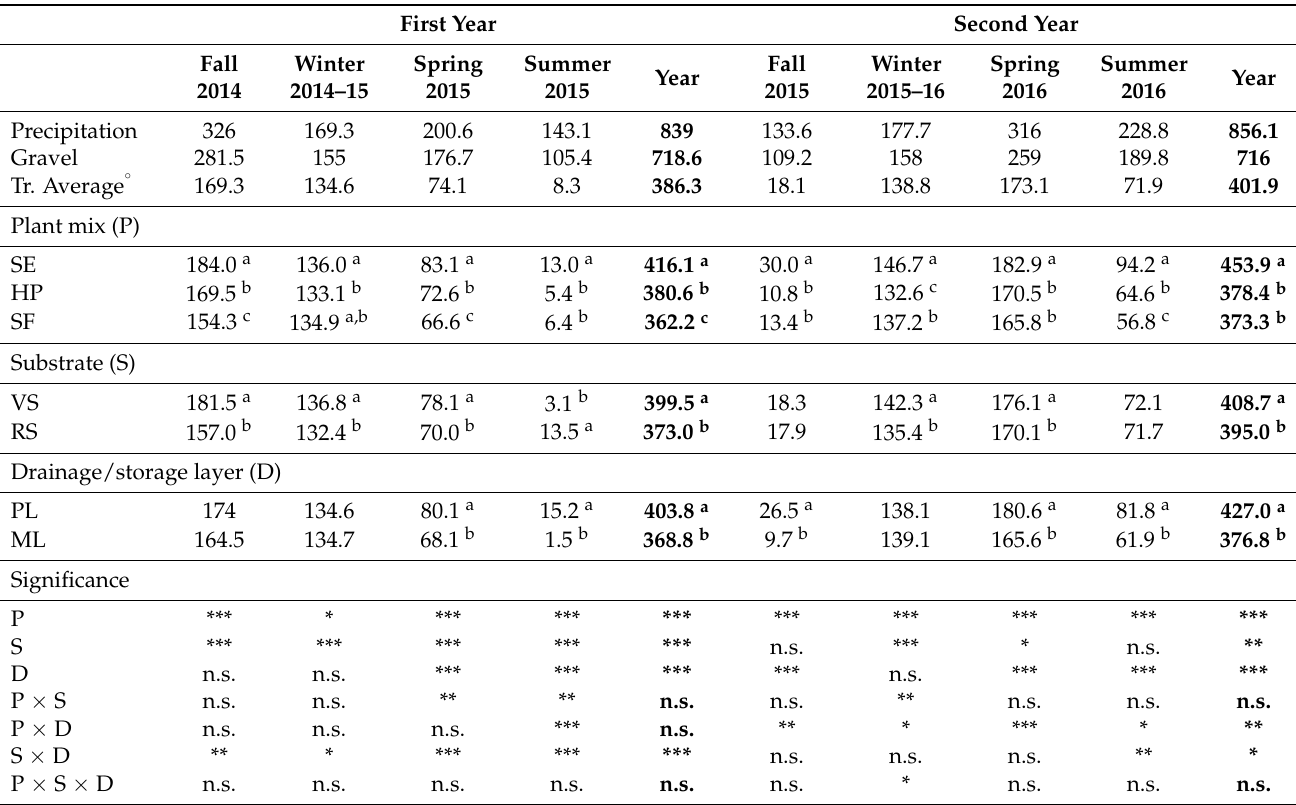
Table 4. Main effects of plant mix, substrate, and drainage/storage layer on the rainwater outflow (mm) from the green roof microcosms in the two-year study in comparison with precipitation and the control (gravel).